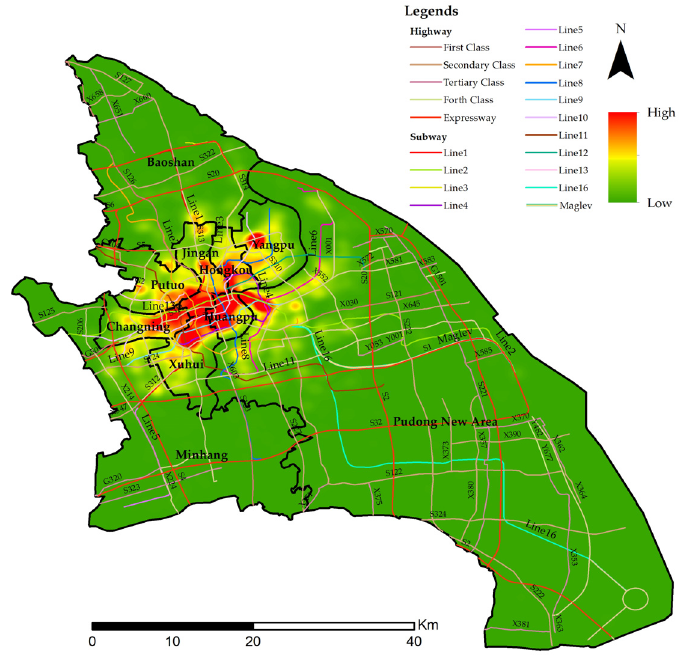
Figure 9. Check-in density of males. Figure 9. Check ‐ in density of males. Figure 9. Check ‐ in density of males.